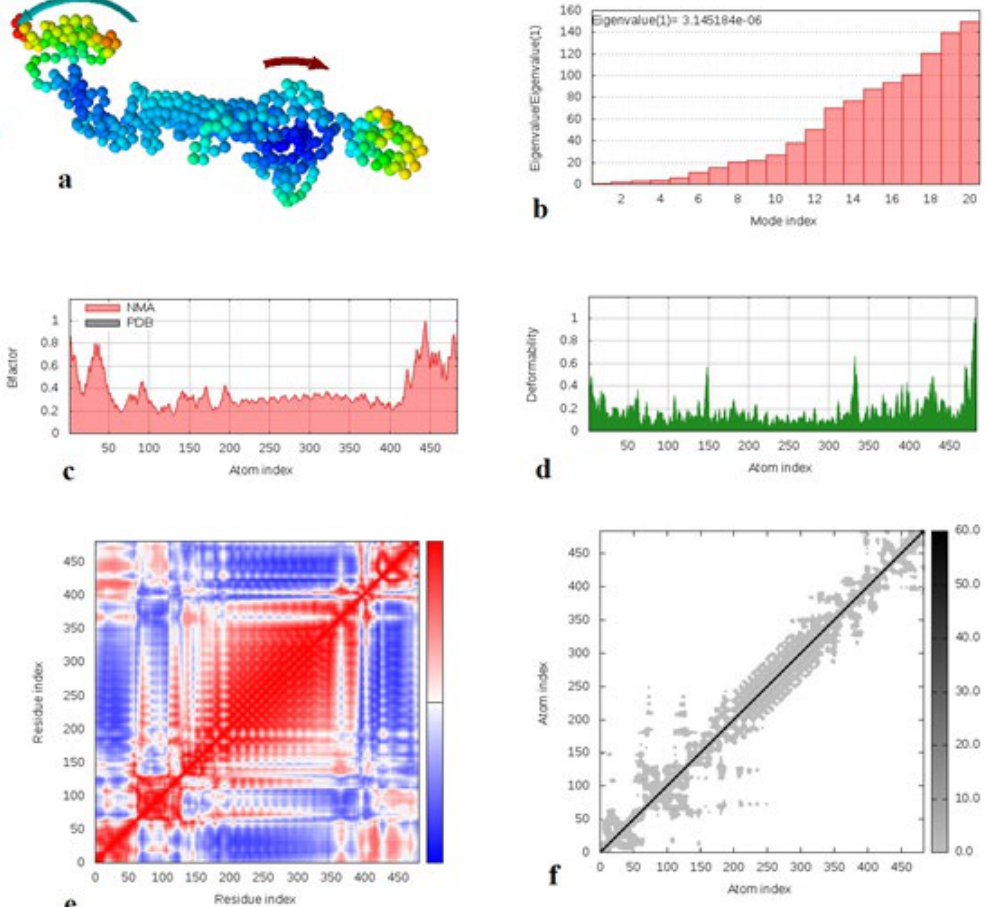
Fig. 8. Molecular dynamics simulation of vaccine protein complex. Stability of the vaccine was analyzed via (a) mobility, (b) eigenvalue, (c) B-factor, (d) deformability, (e) covariance and (f) elastic network